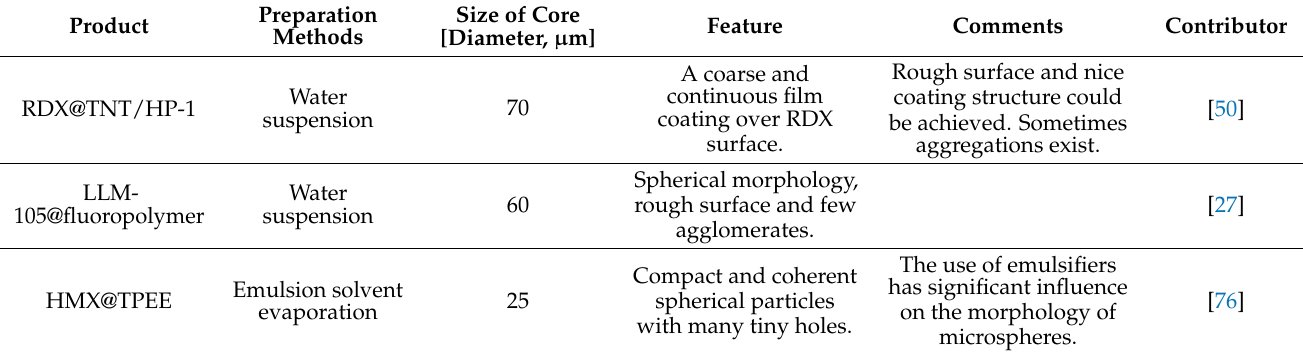
Table 2. Characteristics of the products prepared by water suspension, emulsion, spray drying and other methods.